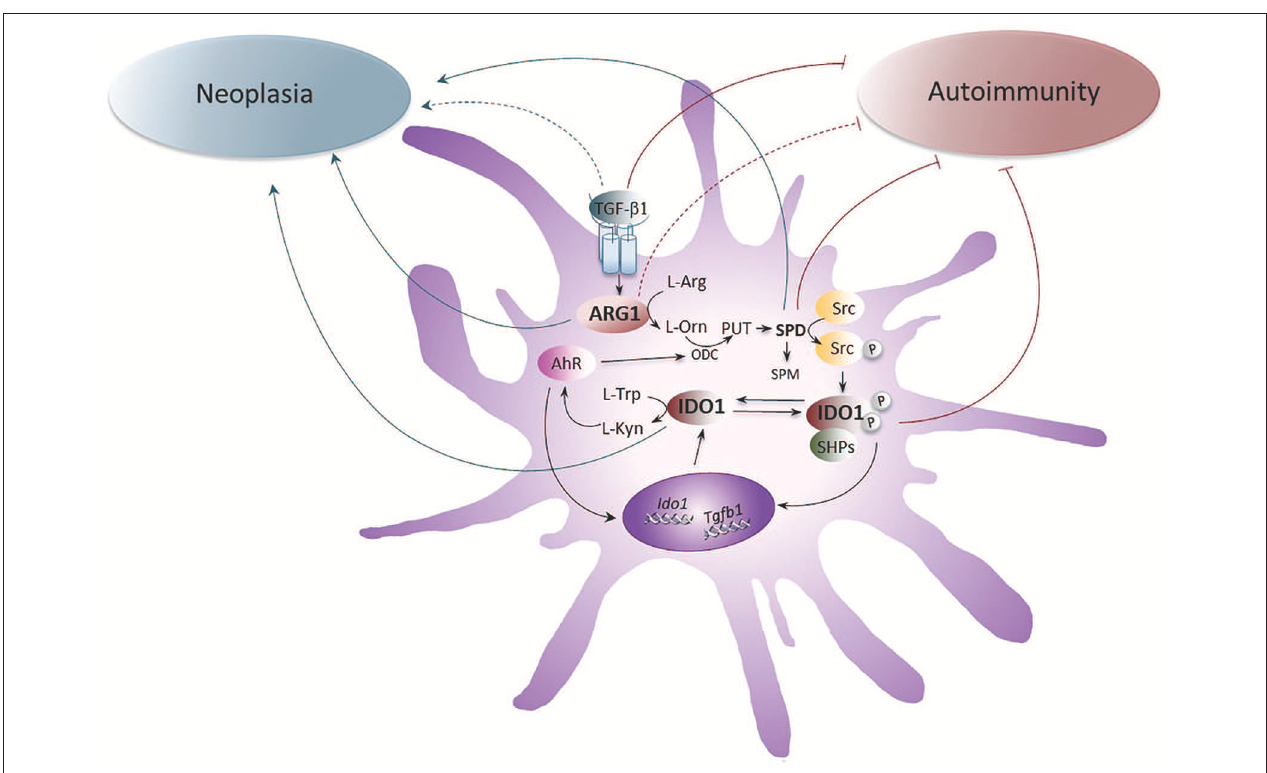
FIGURE 1 | The role of ARG1 and IDO1 in neoplasia and autoimmunity. The up-regulation of ARG1 activity, induced by the cytokine TGF- β , transforms L -arginine ( L -Arg) into L -ornithine ( L -Orn), which is further metabolized by ornithine decarboxylase (ODC) into polyamines (PUT, putrescine; SPD, spermidine; and SPM, spermine). SPD, through the activation of the Src kinase, promotes the phosphorylation of IDO1 and thus favors the initiation of immunoregulatory signaling events in DCs. Once phosphorylated, IDO1 recruits tyrosine phosphatases (SHPs) and promotes a signaling pathway that upregulates the expression of genes coding for IDO1 and TGF- β , thus creating a self-sustaining circuitry responsible for the maintenance of immune tolerance over the long-term. Moreover, IDO1 catalyzes the conversion of L -tryptophan ( L -Trp) into L -kynurenine ( L -Kyn), which activates the aryl hydrocarbon receptor (AhR). AhR further induces IDO1 expression in DCs and sustains the production of polyamines by up-regulating ODC. Whereas the pathogenetic and protective role of TGF- β , SPD, and IDO1 in neoplasia and autoimmunity, respectively, have been demonstrated, the role of ARG1 has been unclear and would require further investigations. Gray arrows indicate the pathogenetic effects of IDO1, ARG1, SPD, and TGF- β 1 receptor signaling in neoplasia and brown arrows indicate the putative protective effects of IDO1, SPD, ARG1, and TGF- β 1 receptor signaling in autoimmune diseases. Dotted lines are for molecules whose role is still